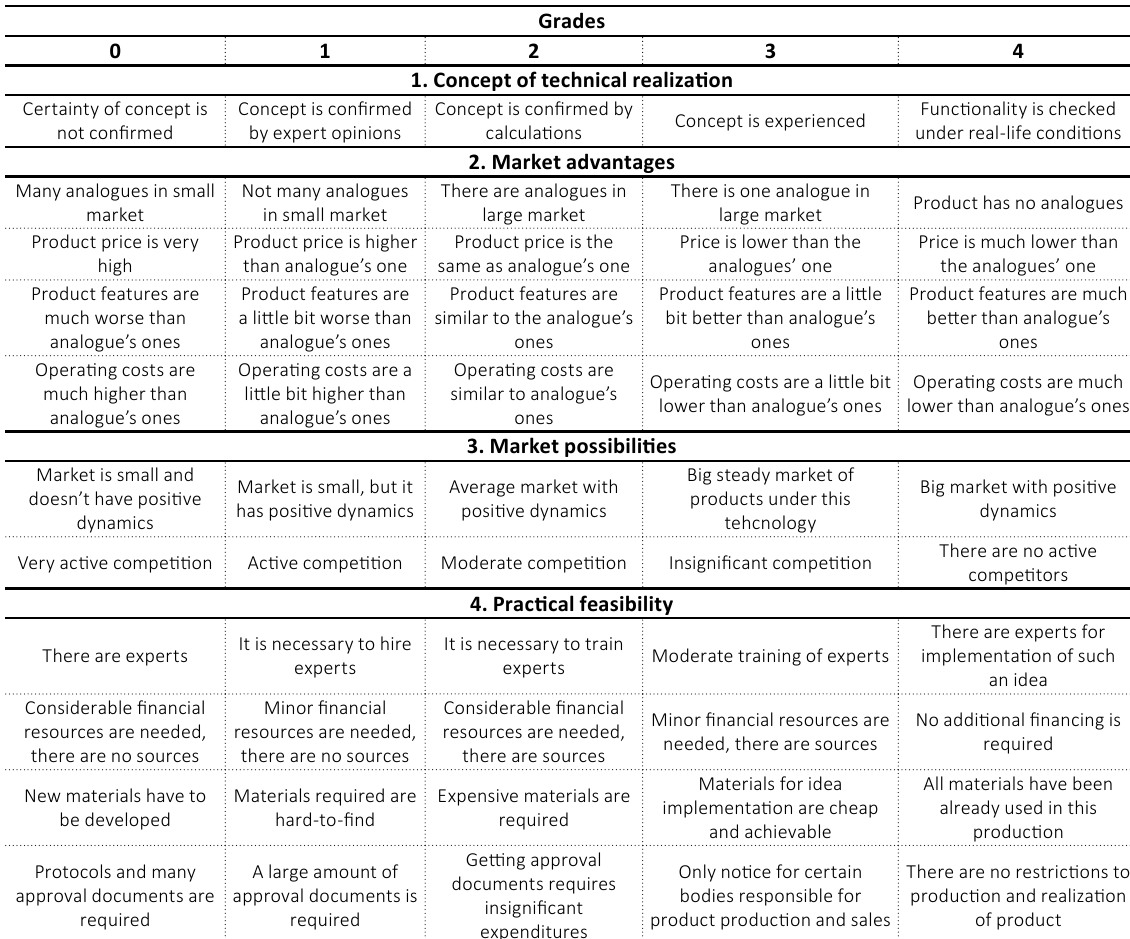
Table 1. Evaluation table of innovative technology market potential as an object of commercialization on the basis of technology